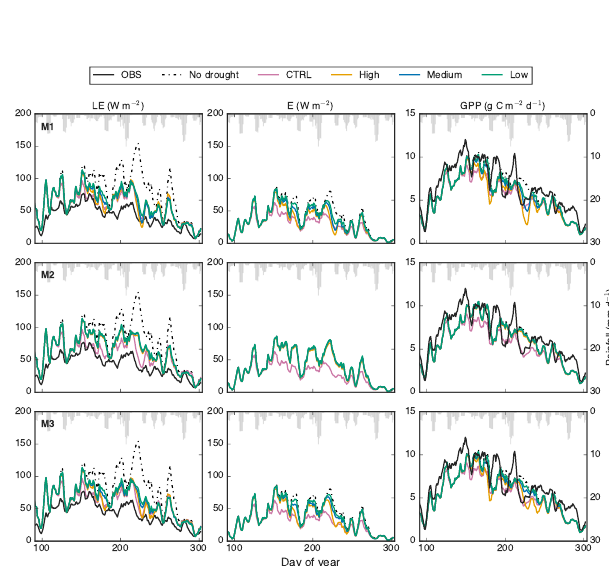
Figure 3. A comparison of the observed (OBS) and modelled la- tent Heat (LE), transpiration ( E ) and gross primary productivity (GPP) at the Tharandt site during 2003. Simulations show the con- trol (CTRL) and the three parameterisations that represent a spec- trum of behaviour ranging from a high to low drought sensitivity, and the tested methods to obtain a weighted estimate of soil water potential ( (cid:57) S ) across CABLE’s soil layers (M1–M3). M1 uses a root-biomass weighted soil water content converted to (cid:57) S , M2 cal- culates (cid:57) S by integrated soil water content over the top 1.7m of the soil, and M3 is calculated using a dynamic weight across soil layers. The data have been smoothed with a 5-day moving window to aid visualisation and the grey bars show daily